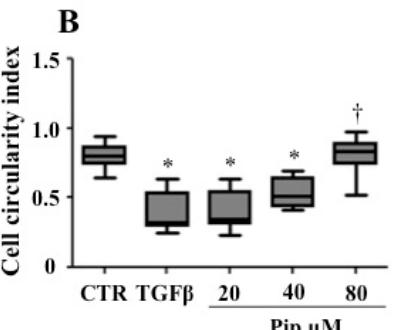
Figure 3. Pretreatment with piperine modulates TGF- β 1-induced morphological changes in A549 cells. ( A ) A549 cells were pretreated with non-cytotoxic doses of piperine (20, 40 and 80 µ M) for 24 h followed by treatment with 1 ng / mL TGF- β 1 for 48 h, then followed by the observation under phase-contrast microscopy, scale bar = 100 µ M. ( B ) After TGF- β 1 treatment, cells acquired spindle-shaped morphology. Pretreatment with piperine 40 and 80 µ M attenuated or suppressed such event, respectively. Data are representative of 500 cells from three independent experiments ± SD. * p ≤ 0.05 vs. untreated cells (CTR); † p ≤ 0.05 vs. TGF- β .